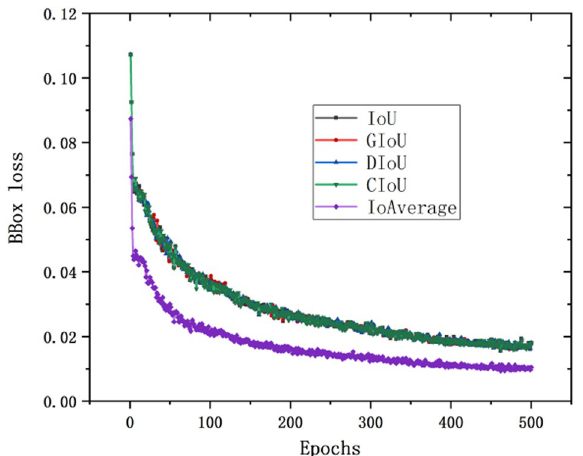
Fig. 7 The variation of bounding box loss value with epochs using different schemes on the training dataset